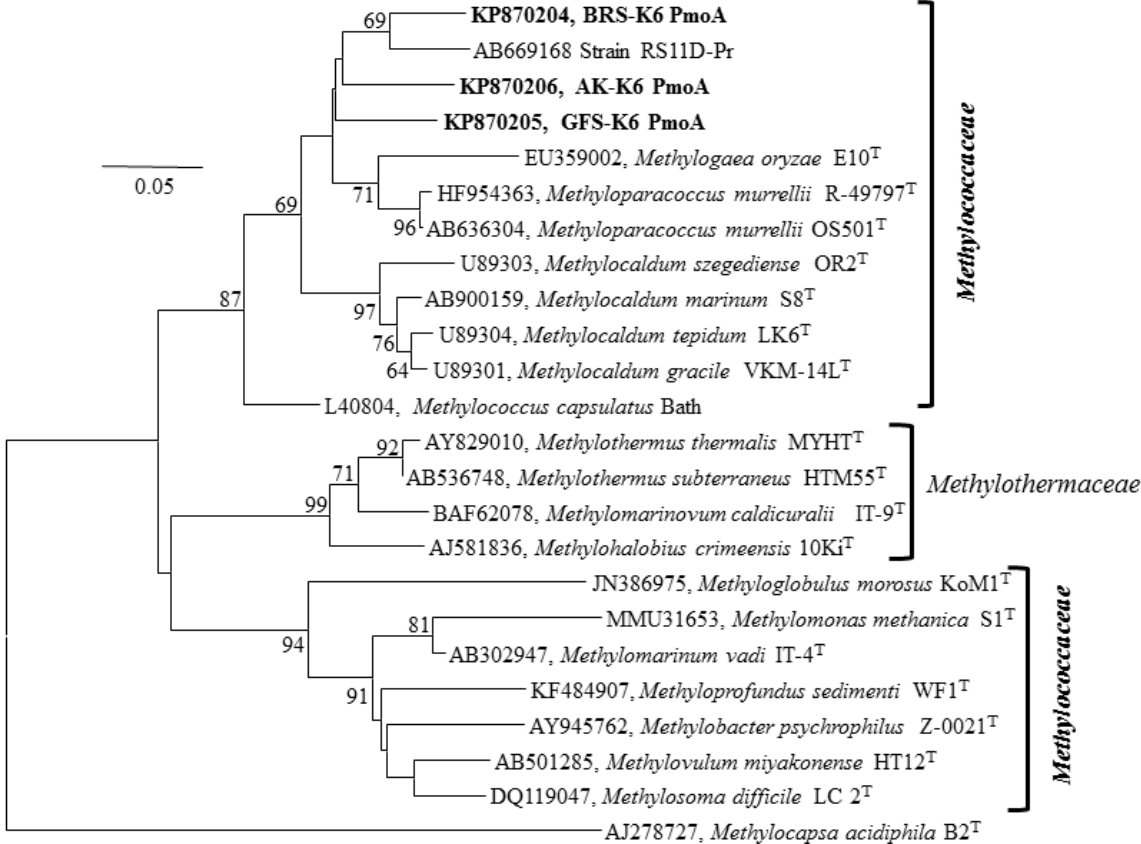
Figure 3. Neighbour joining tree (1000-replicate bootstrapping) based on the deduced PmoA amino acid sequences of strains BRS-K6, GFS-K6 and AK-K6 and from other cultured methanotrophs of the families Methylococcaceae and Methylothermaceae . The type II methanotroph Methylocapsa acidophila (AJ278727), of the class Alphaproteobacteria , was used as an outgroup. GenBank accession numbers are given in front of the name of respective isolates. Bar, 0.05 substitutions per amino acid